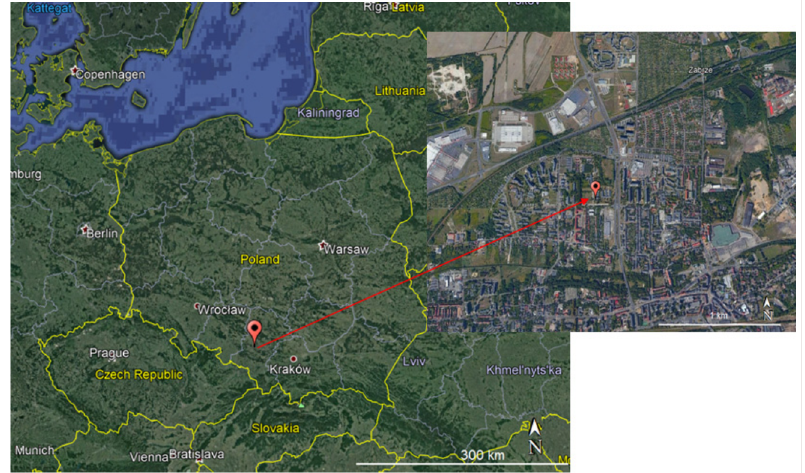
Figure 1. Location of the study area and surroundings of measurement station selected for